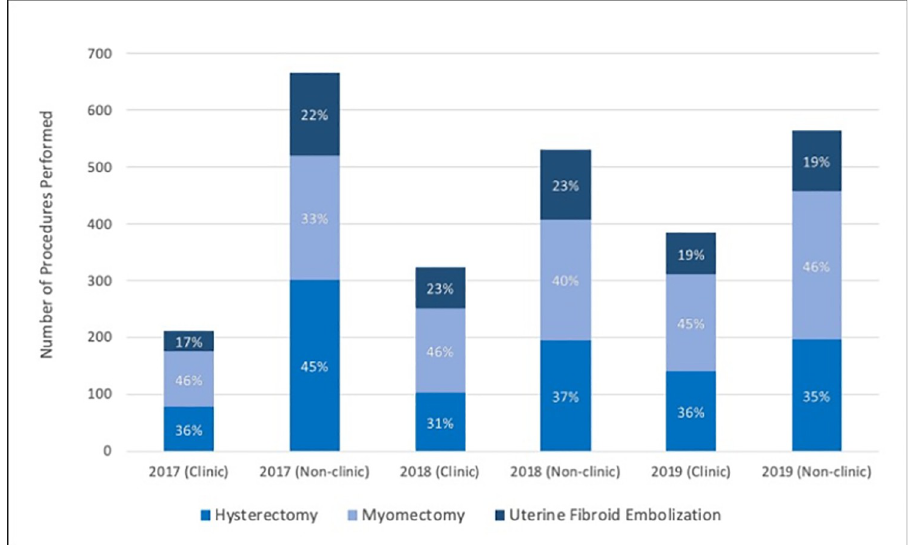
Fig 2. Annual rates of procedures for symptomatic uterine fibroids from the multidiciplinary clinic verses the rest of the healthcare system displayed in terms of relative percentages of one procedure compared to others. There was no significant difference between clinic and non-clinic rates (p =